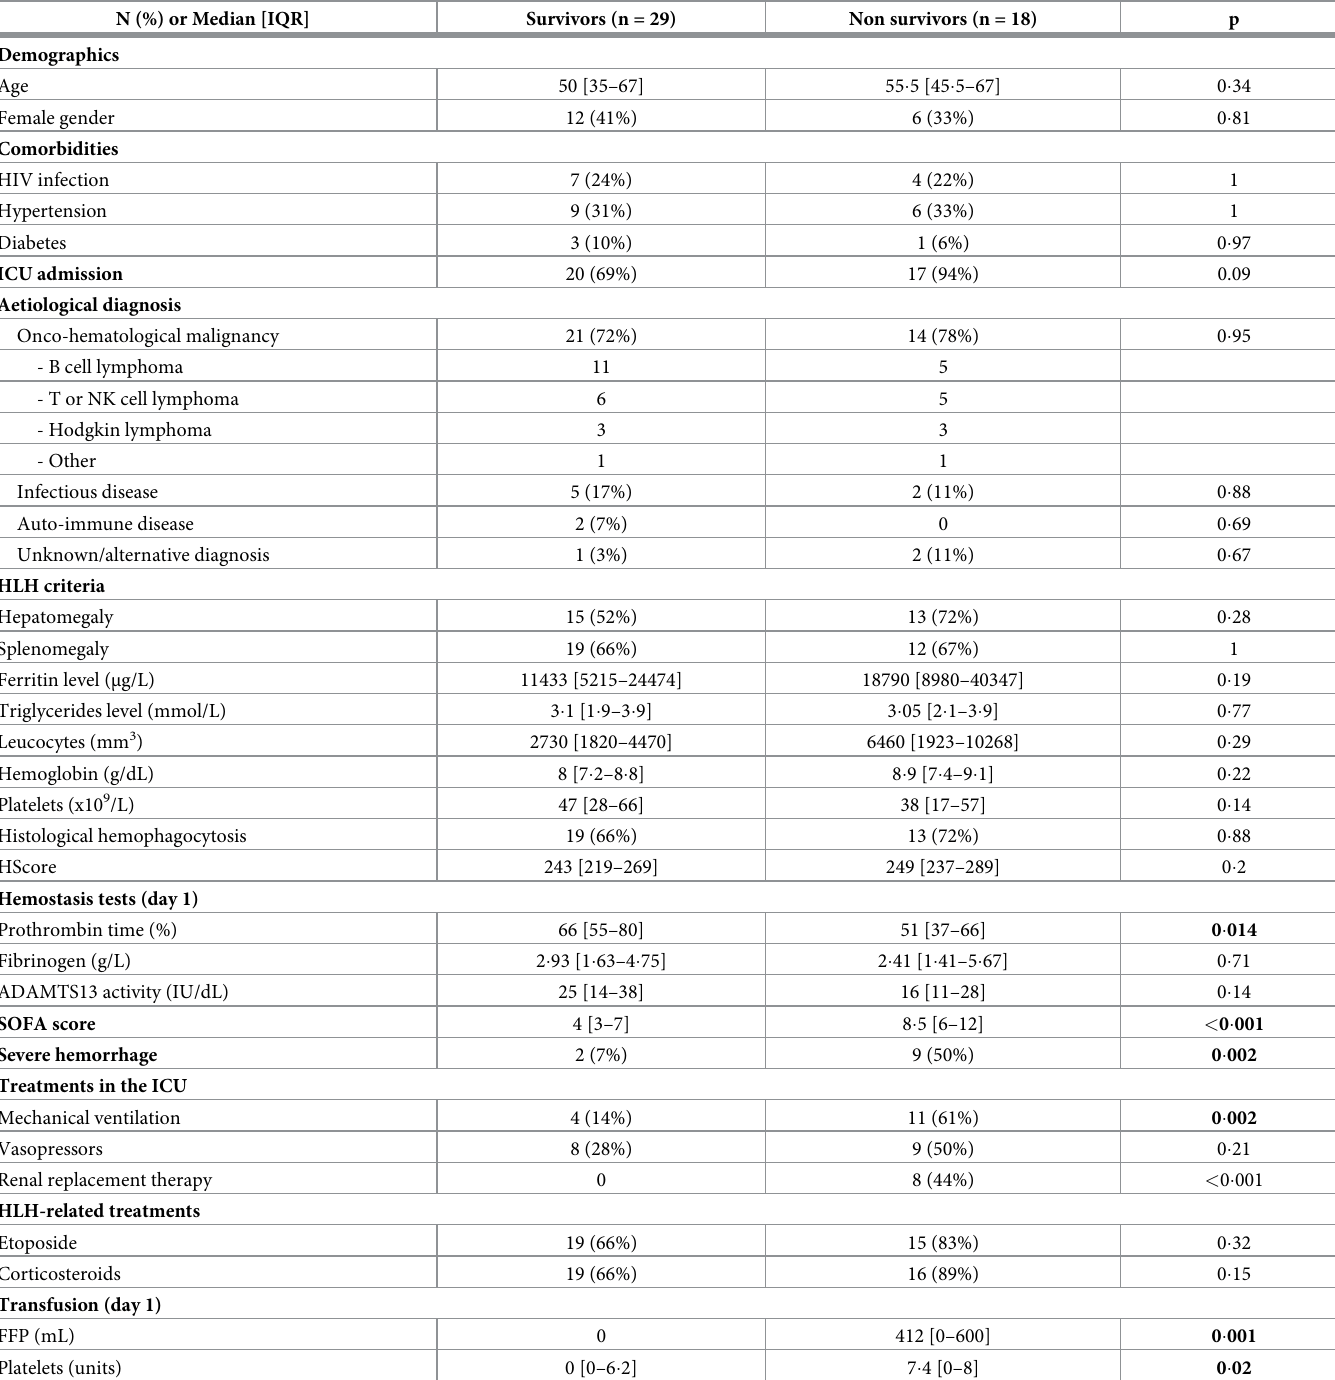
Table 1. Characteristics of patients with hemophagocytic lymphohistiocytosis according to the outcome. N (%) or Median